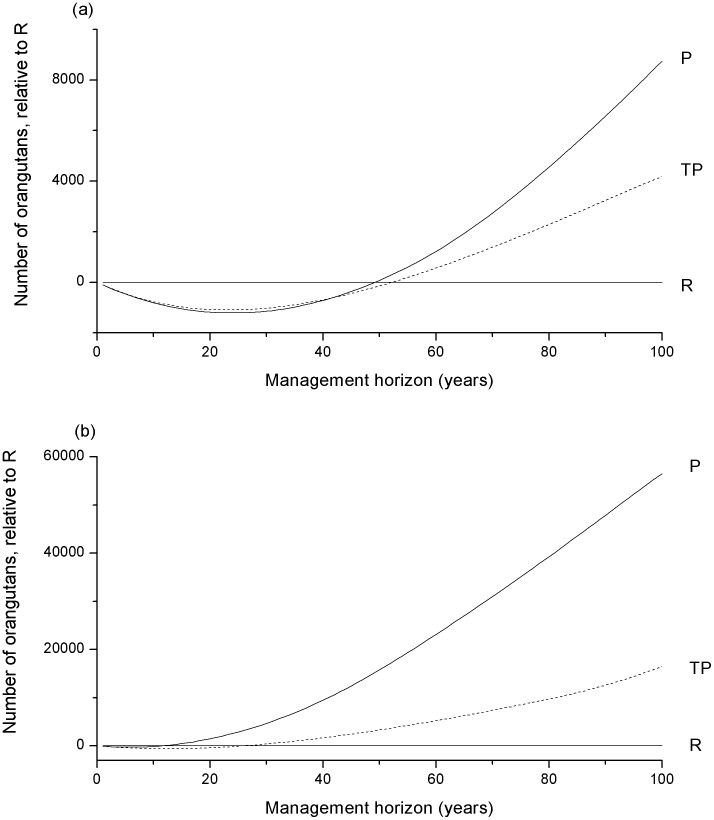
The relative performance of different strategies.The y-axis shows the difference between the number of orangutans for each strategy relative to the R strategy (with reintroduction into conservation areas). R compared to itself is a straight line at zero, above zero a strategy performed better than R, below zero a strategy performed worse than R. The strategy P protects conservation areas first. The strategy TP introduces sustainable logging and protection into timber production forest first. The budget was $5M per year, other parameters are in Table 2. (a) Without hunting or orangutan population growth. The critical time horizon is 49 years for P, and 52 years for TP. (b) Hunting and orangutan population growth included. The critical time horizon is 12 years for P, and 25 years for TP.